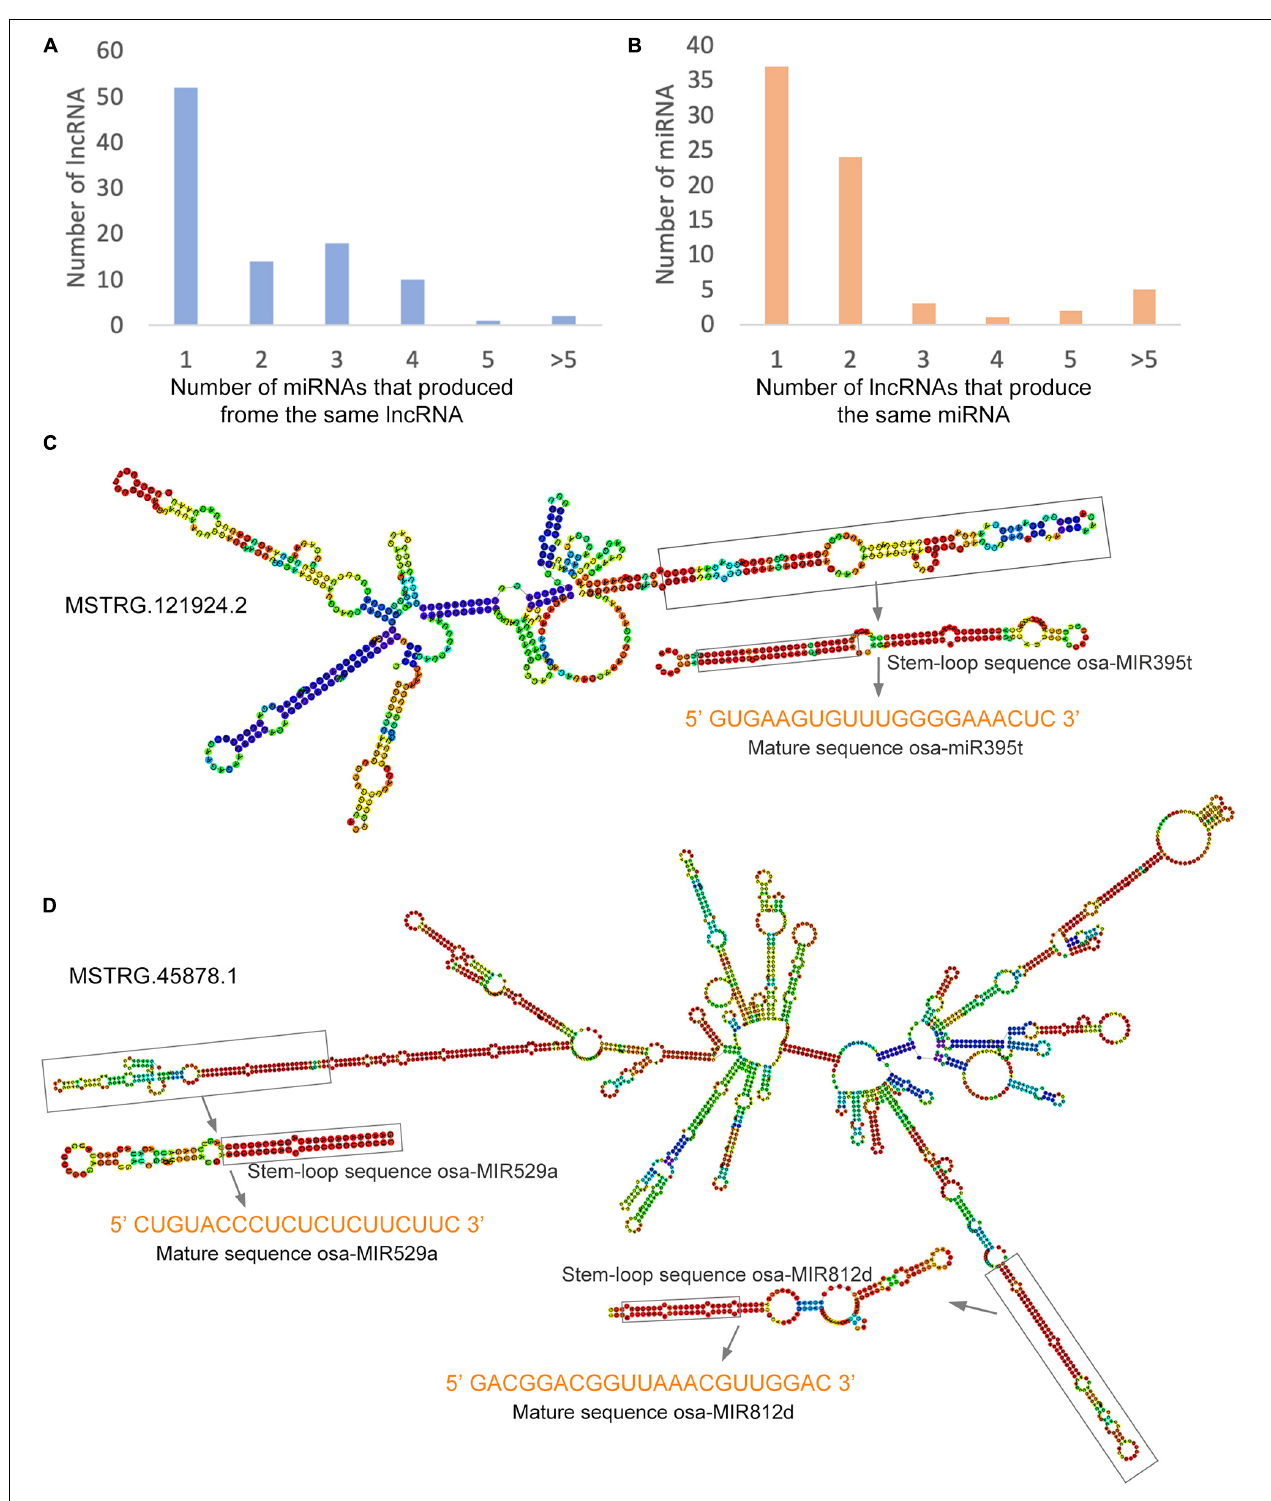
FIGURE 7 | LncRNAs as precursors of miRNAs in the PTGMS rice line. (A) The number of miRNAs produced by lncRNAs. (B) Number of lncRNAs that produce the same miRNA. (C) Predicted secondary structure of MSTRG.121924.2, which contains only one precursor sequence of osa-miR395t. (D) Predicted secondary structure of MSTRG.121924.2, which contains two precursors of osa-miR529a and osa-miR812d. The predicted secondary structures were predicted using RNAfold. The color scale indicates high (red) to low (blue) probabilities of base pairing.